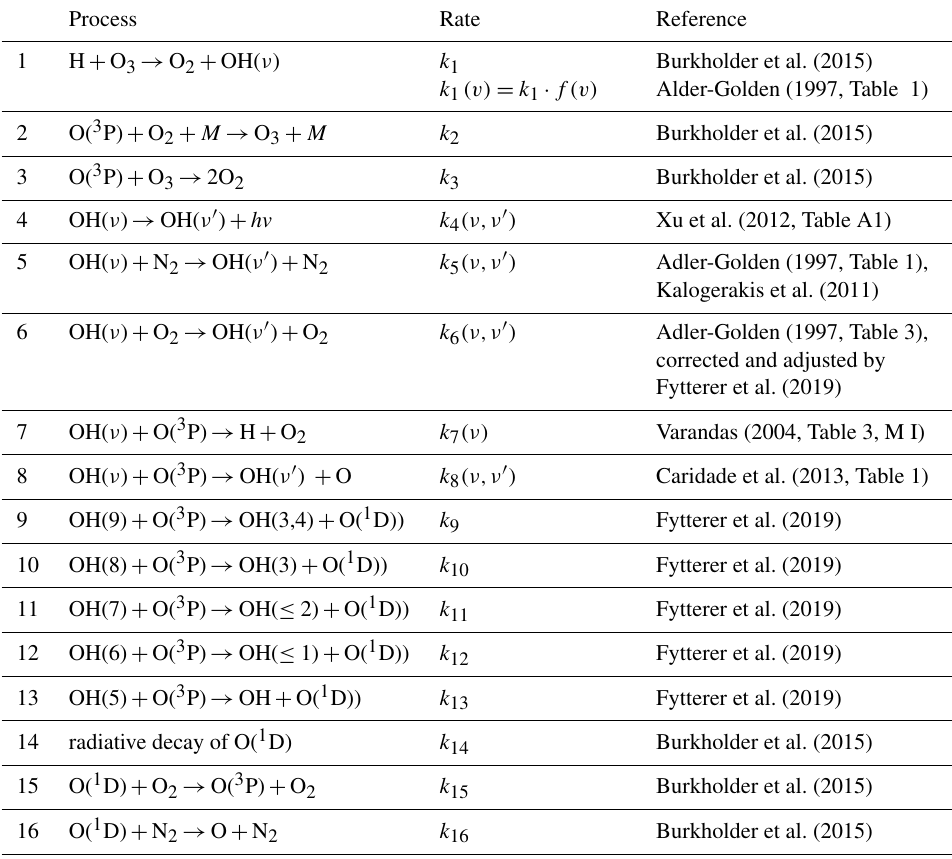
Table 1. List of processes.